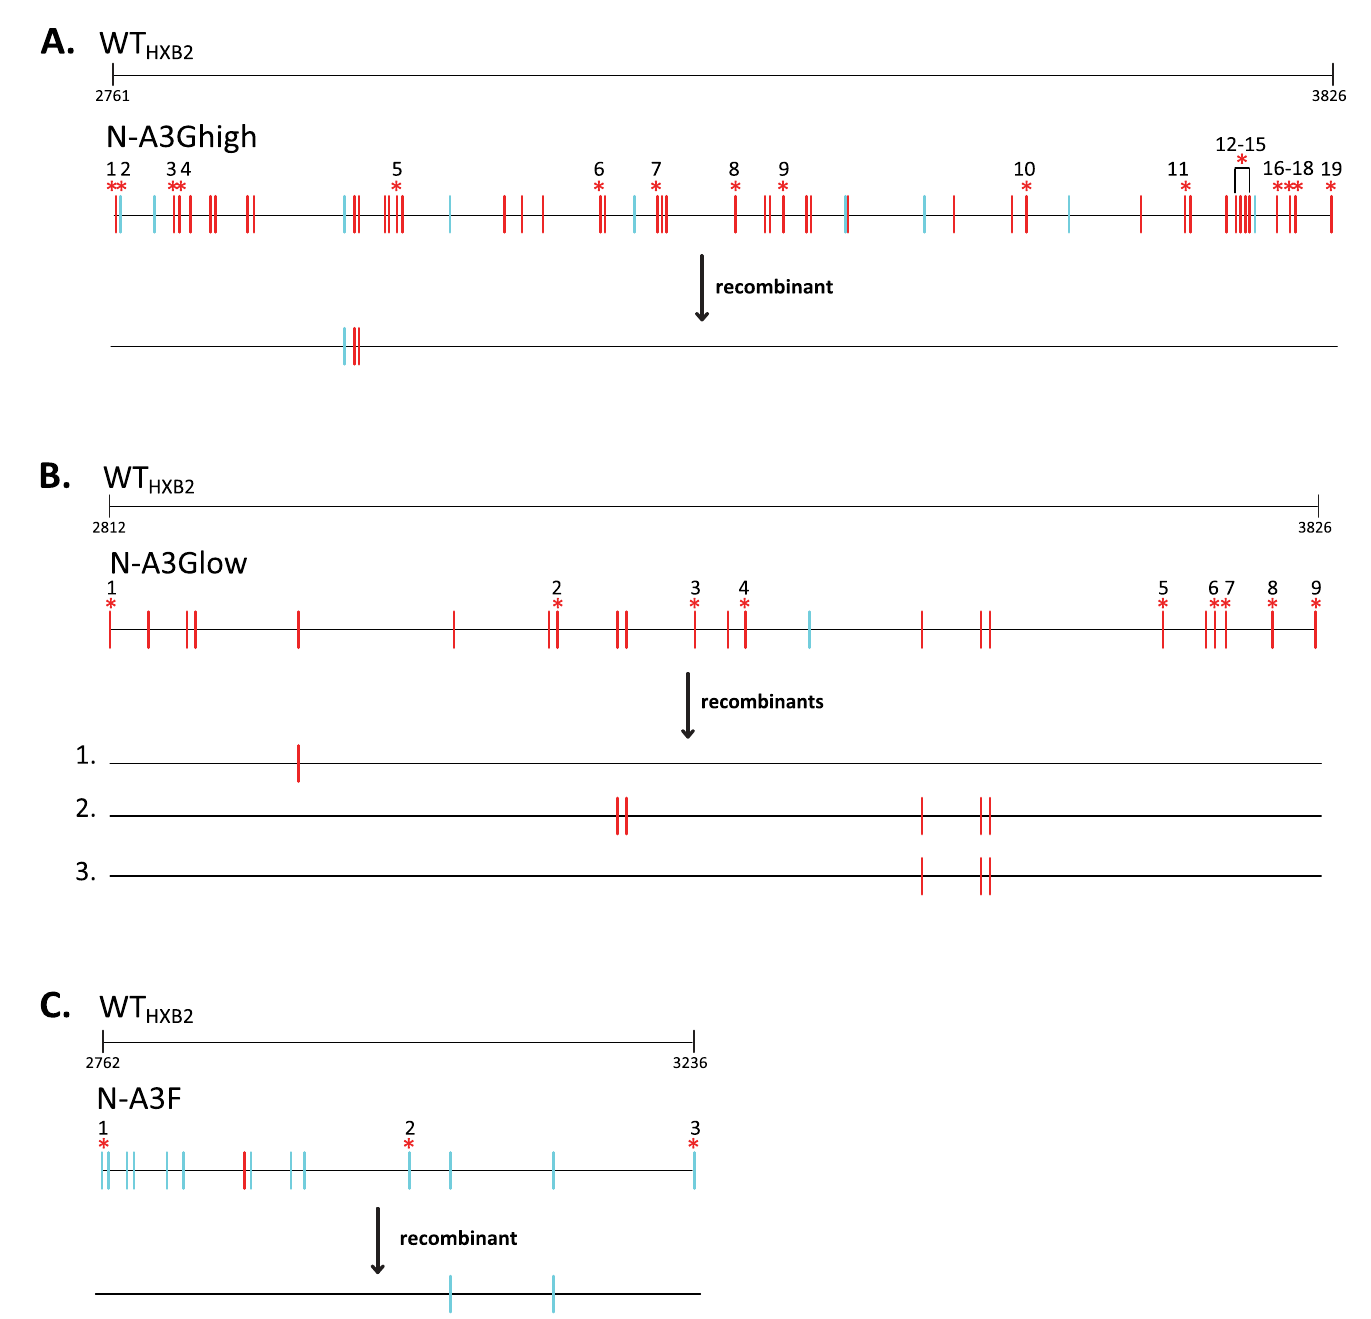
Fig 3. Recombinants with G-to-A changes after single-cycle recombination assay. Distribution of G-to-A changes (relative to WT HXB2 ) for parental N-A3Ghigh (A), N-A3Glow (B), and N-A3F (C) pairs, and for resulting recombinants with non-lethal G-to-A changes. Shown are the G-to-A changes retained by each of the recombinants: one recombinant from WT HXB2 /N-A3Ghigh, three recombinants from WT HXB2 /N-A3Glow, and one recombinant from WT HXB2 /N-A3F. A total of 14 G-to-A changes were observed in these 5 recombinants. G-to-A changes in the GG ! AG and GA ! AA dinucleotide context are shown as red and blue vertical lines, respectively (Hypermut [102]; www.hiv.lanl.gov), while lethal G-to-A changes that introduce stop codons are marked by * and numbered. Nucleotide numbering corresponds to HXB2 (GenBank Accession number K03455).